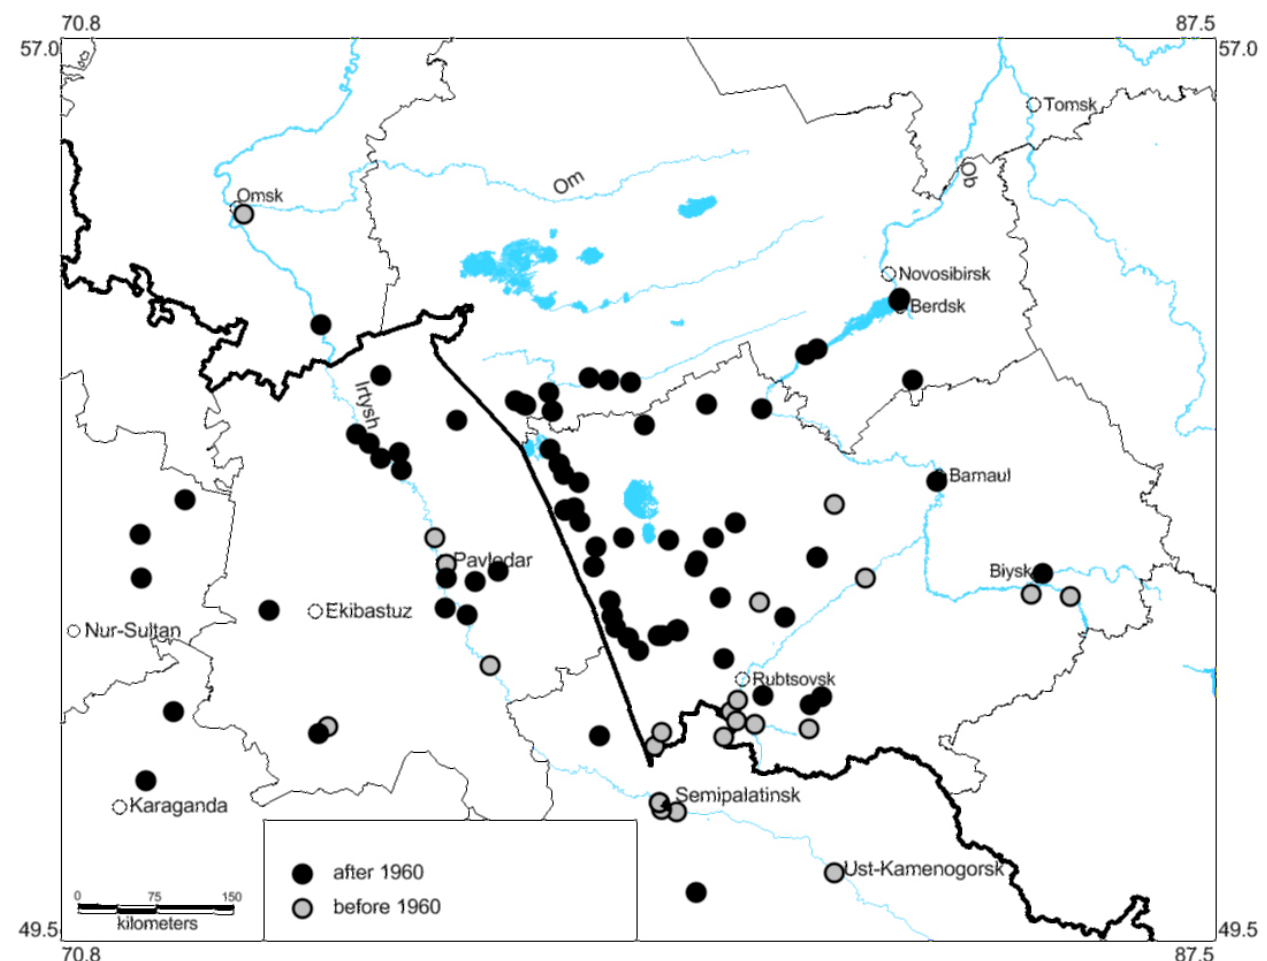
Figure 1. Distribution of Oedaleus decorus over the south-eastern part of the West Siberian Plain until 1960 and after 1961.